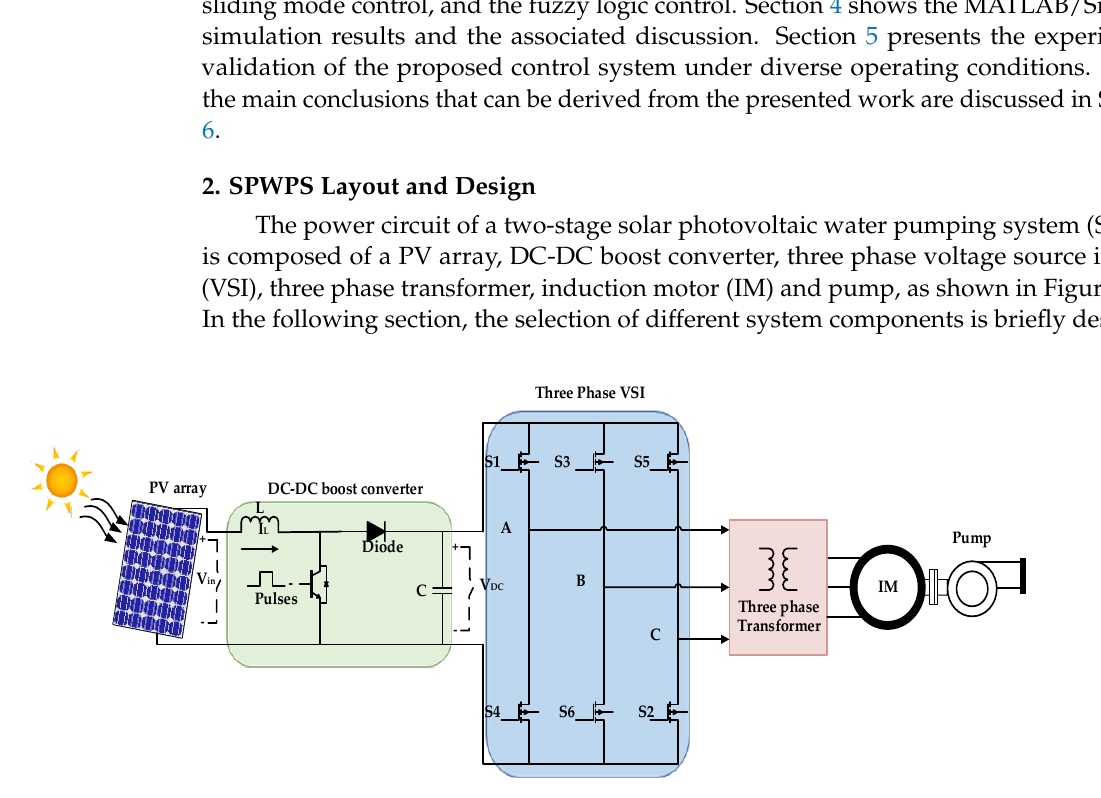
Figure 1. The power circuit for the direct-coupled solar photovoltaic energy (PV) water pumping system.